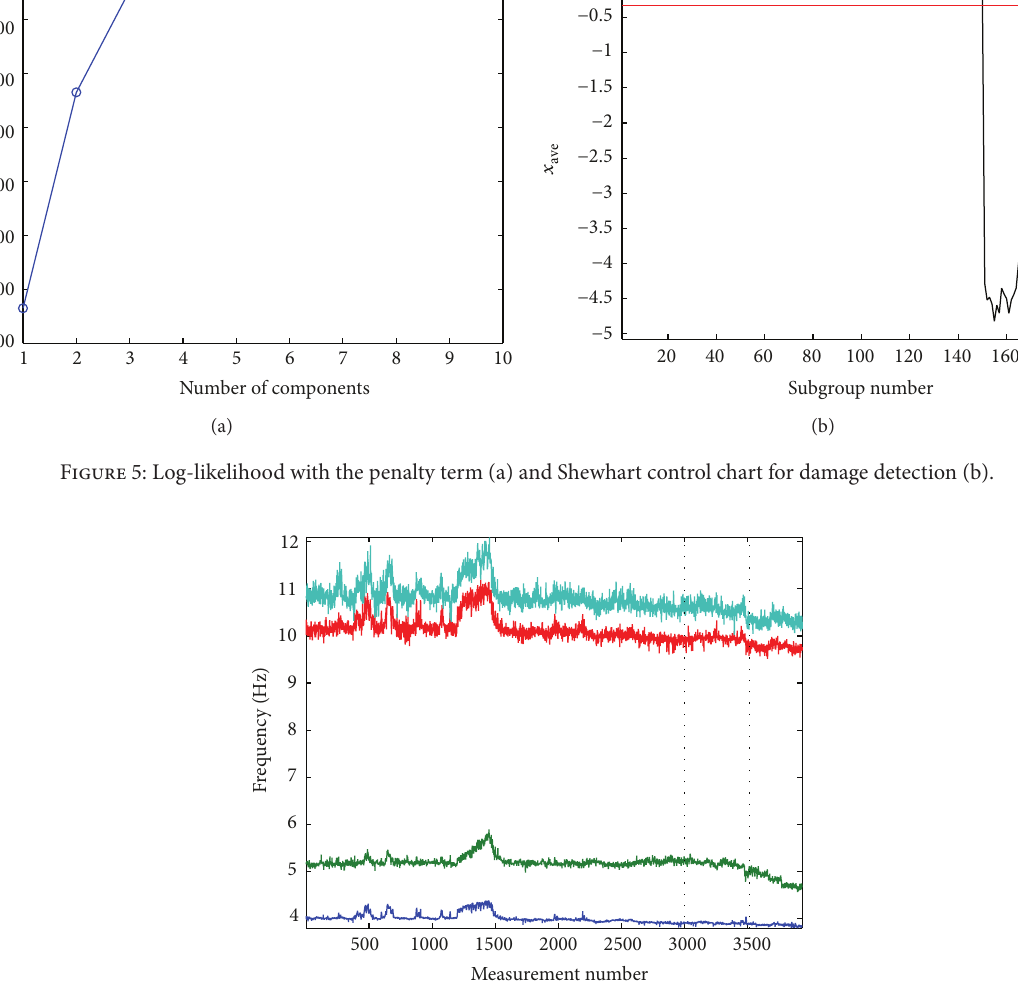
Figure 6: Identified lowest natural frequencies of the Z24